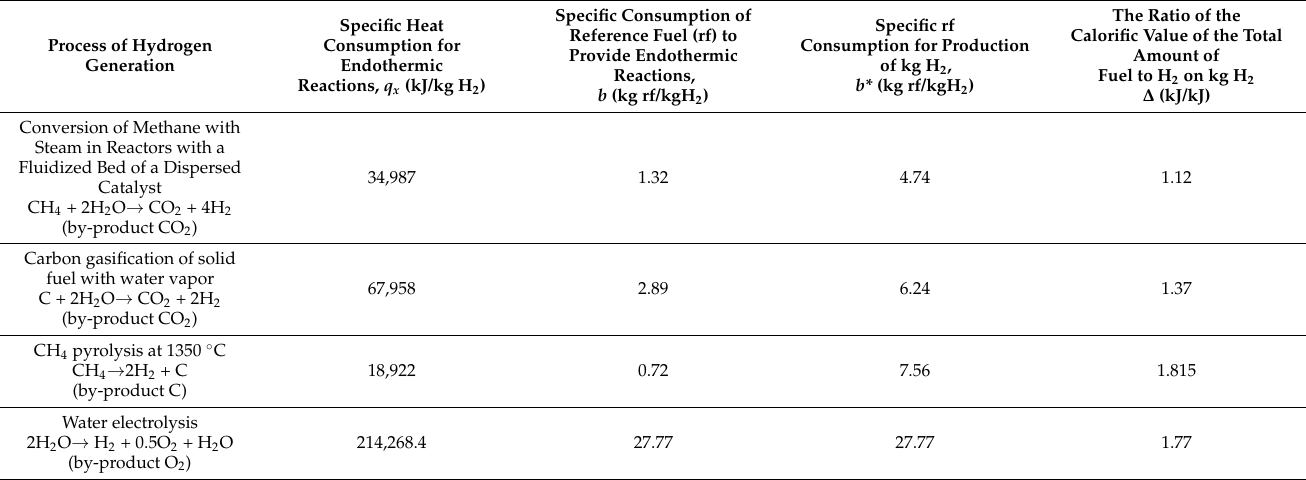
Table 1. Comparison of energy efficacy of different processes of hydrogen